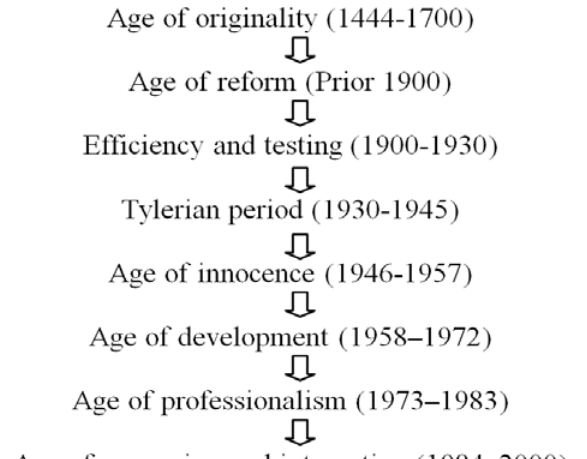
Fig. 1. Ages in the evolution of program evaluation